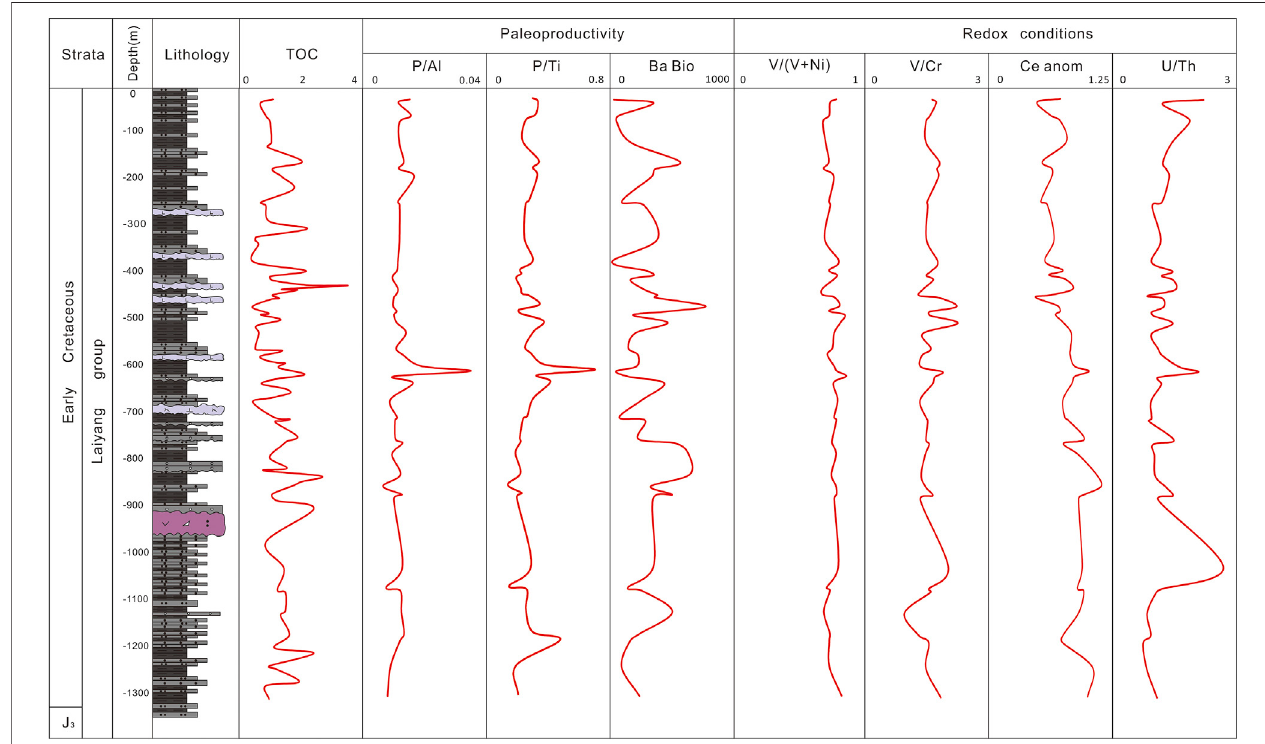
FIGURE 5 | Stratigraphic distribution of TOC, paleoproductivity proxies, redox proxies, in well LK-1.